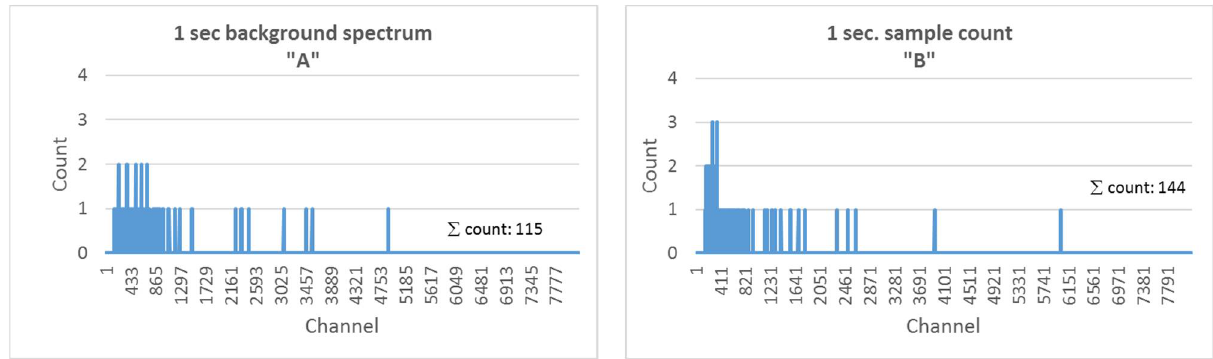
Figure 2. Background radiation ( A ) and the low-activity sample ( B ) of a 1-s measurement. Analyzing the spectrum, it can be seen that using the sample, additional events were observed in the channels that were not seen in the background, that is two events without increasing to three with the sample. If the full spectrum of the detector signals is analyzed, the signal-to-noise ratio is as